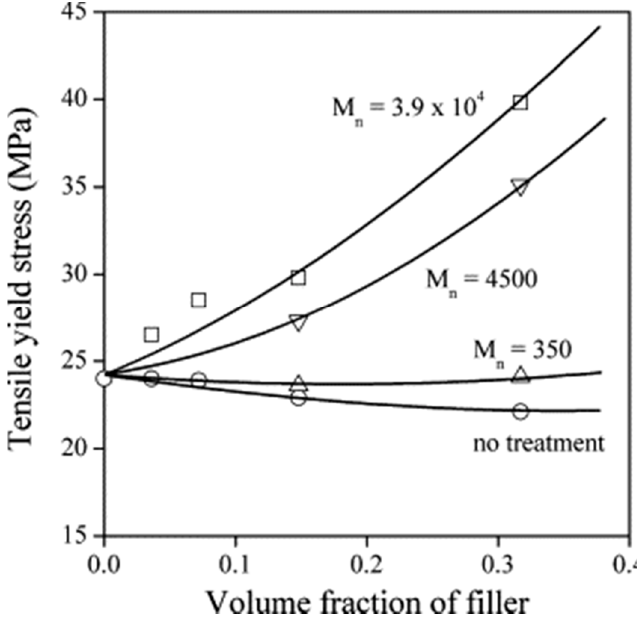
Figure 11. Effect of the interdiffusion of the functionalized polymer with the matrix on the me- chanical properties of PP/cellulose composites. Reprinted from Ref. [20] (© 2008 The Korean Society of Industrial and Engineering Chemistry. Published by Elsevier B.V.).